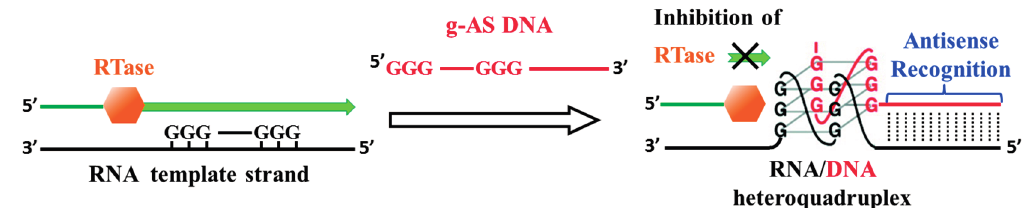
Figure 7. Inhibition of reverse transcription by an antisense-induced RNA-DNA G-quadruplex. A guanine-tethered antisense DNA (g-AS, shown in red) hybridized to a target RNA; then contiguous guanines in both the RNA and the g-AS associated to form a G-quadruplex structure that block the elongation process of RT